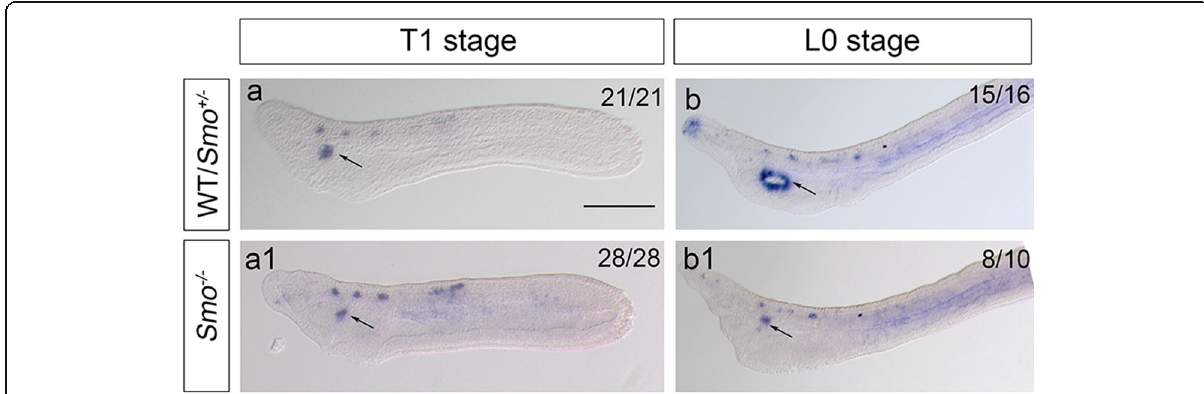
Fig. 6 Pou4 expression during mouth development in the amphioxus. Images of B. floridae at the tail bud stage (T1 stage) and the open mouth stage (L0 stage) from the left lateral view. Black arrows mark the mouth region, scale bar, 100 μ m. a, a1: Pou4 is expressed focally in the regions destined to form the mouth (a), Smo gene knockout has no effect on Pou4 expression (a1). b, b1: Pou4 is expressed at the margin of the mouth at the L0 stage. Smo knockout results in diminished Pou4 expression at the mouth margin with the complete loss of mouth